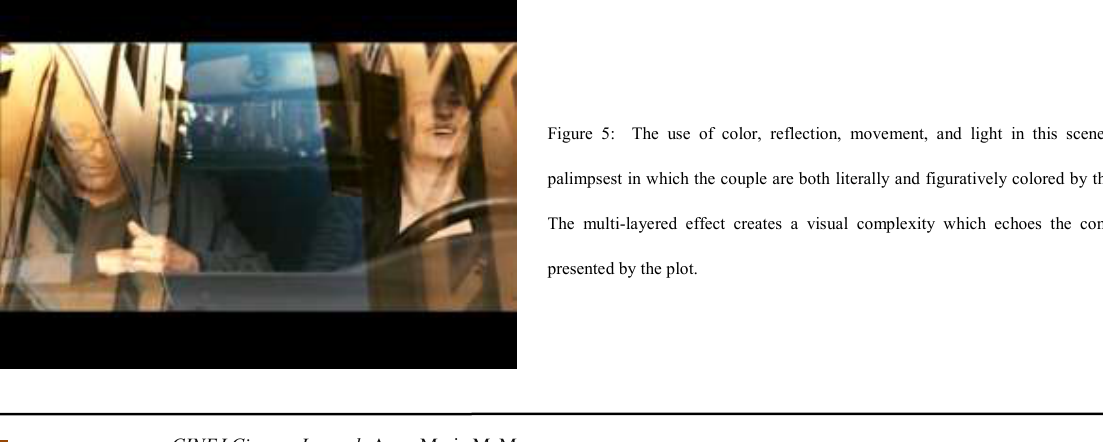
Figure 5: The use of color, reflection, movement, and light in this scene form a kind of palimpsest in which the couple are both literally and figuratively colored by their surroundings. The multi-layered effect creates a visual complexity which echoes the complexity of ideas presented by the